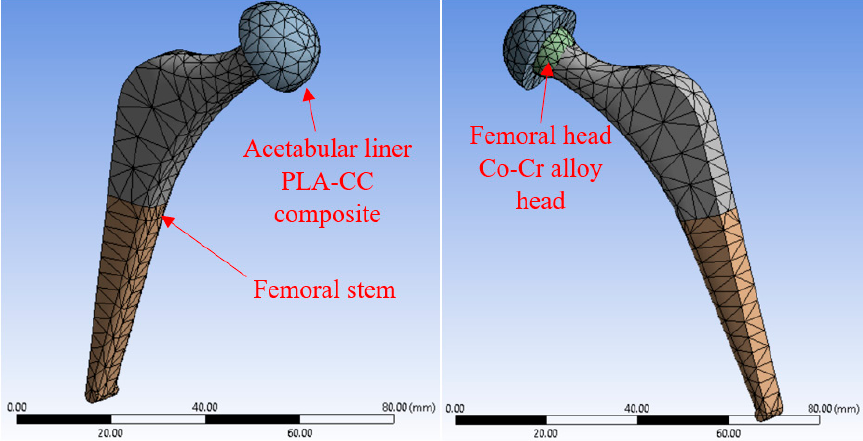
Figure 3. The finite element model of the hip joint.